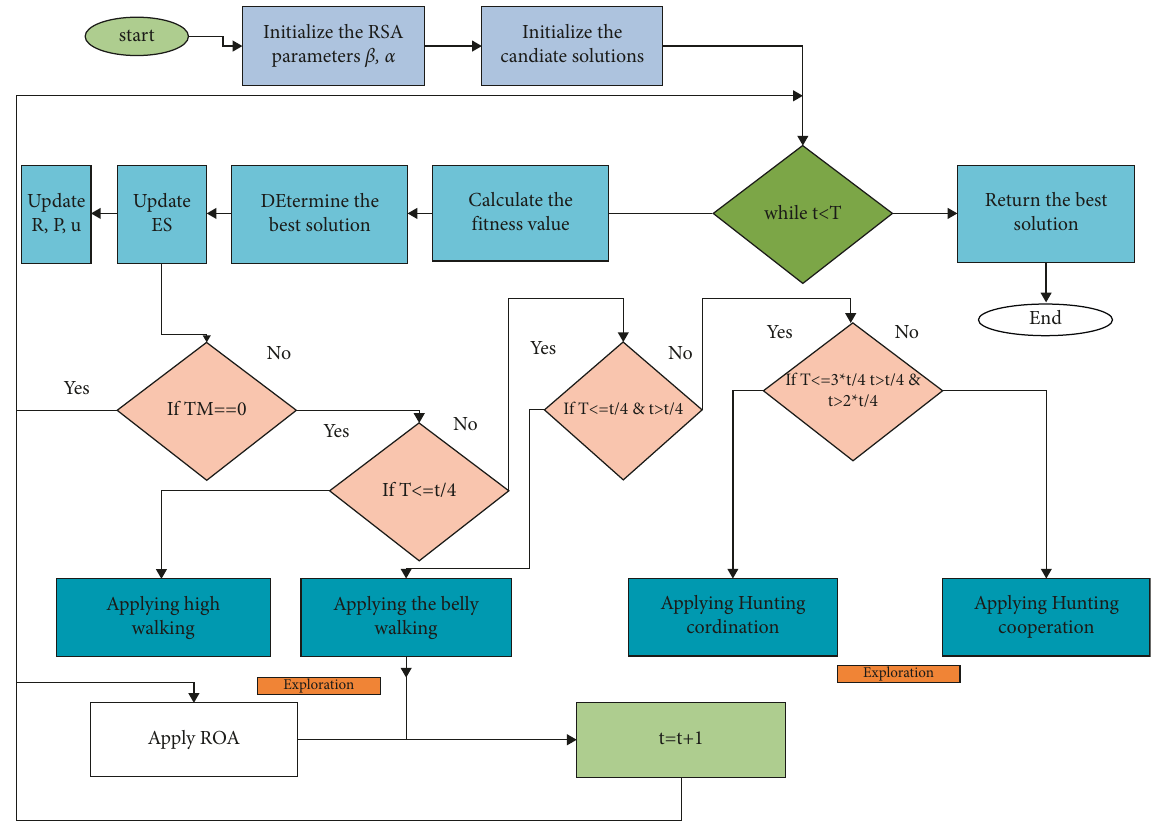
Figure 1: Flow chart of the proposed hybrid model.